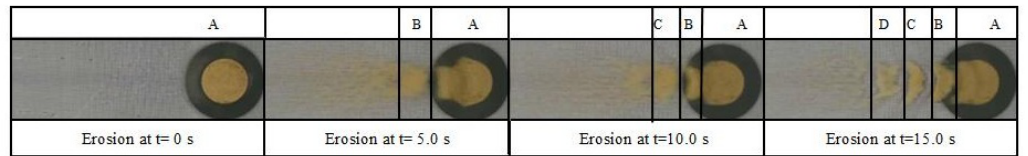
Figure 8: Time-dependent development of crescent zones for d 50 = 0.30 mm soil sample with Q = 3.57